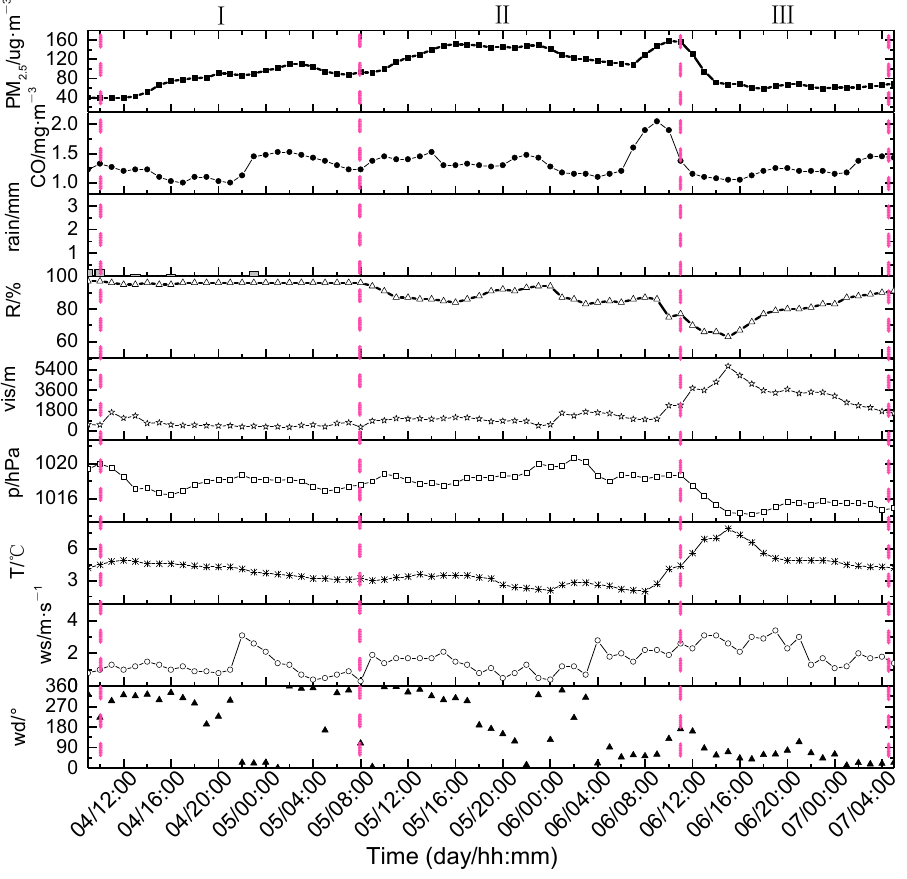
Figure 2. Hourly variations of surface PM 2.5 , CO concentrations and meteorological element at Xianning station during 4 to 7 January, 2019.